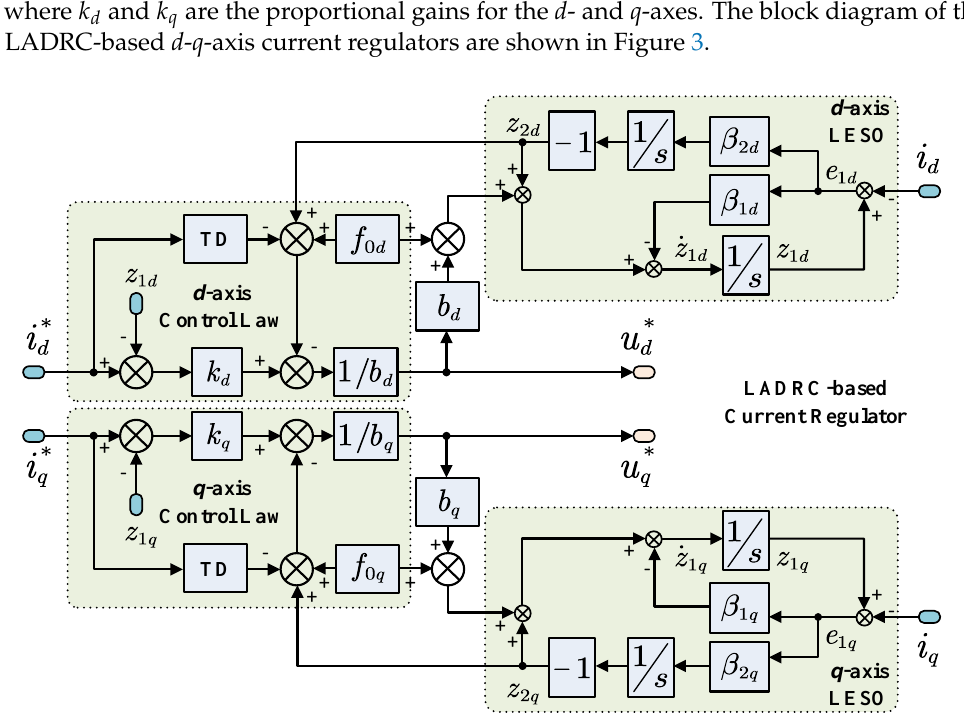
Figure 3. Block diagram of the LADRC-based d - q -axis current regulators.